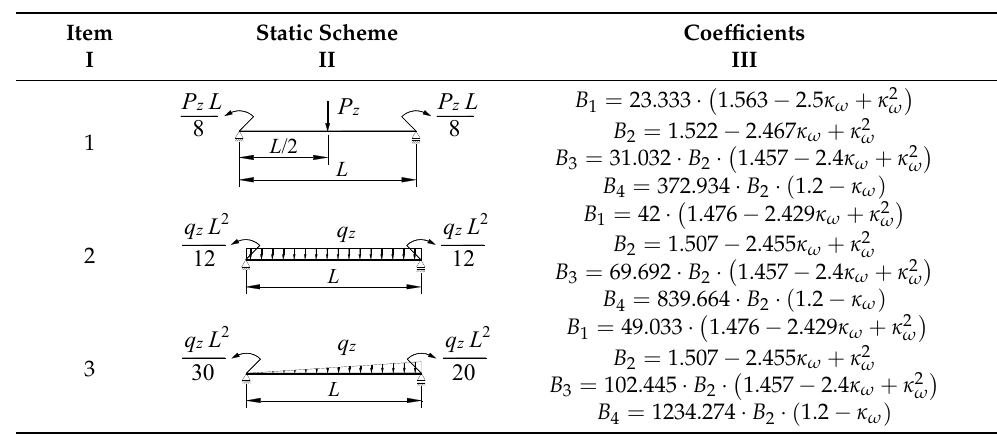
Table 4. Coefficients B 1 , B 2 , B 3 , and B 4 for selected static schemes of fixed beams ( M cr,u ).